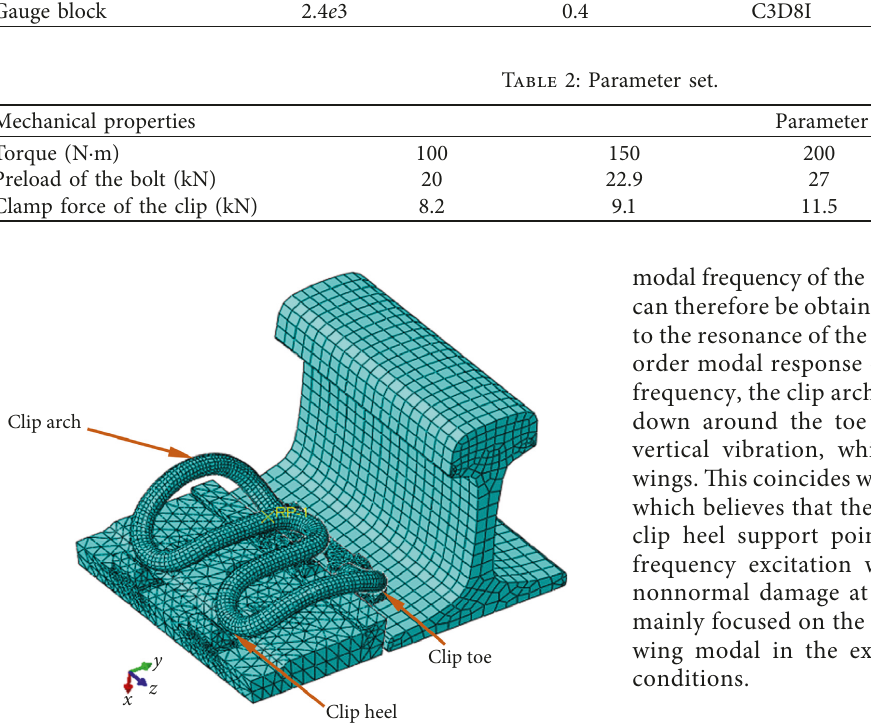
Figure 8: FEA model of fastening with the ω -type clip.